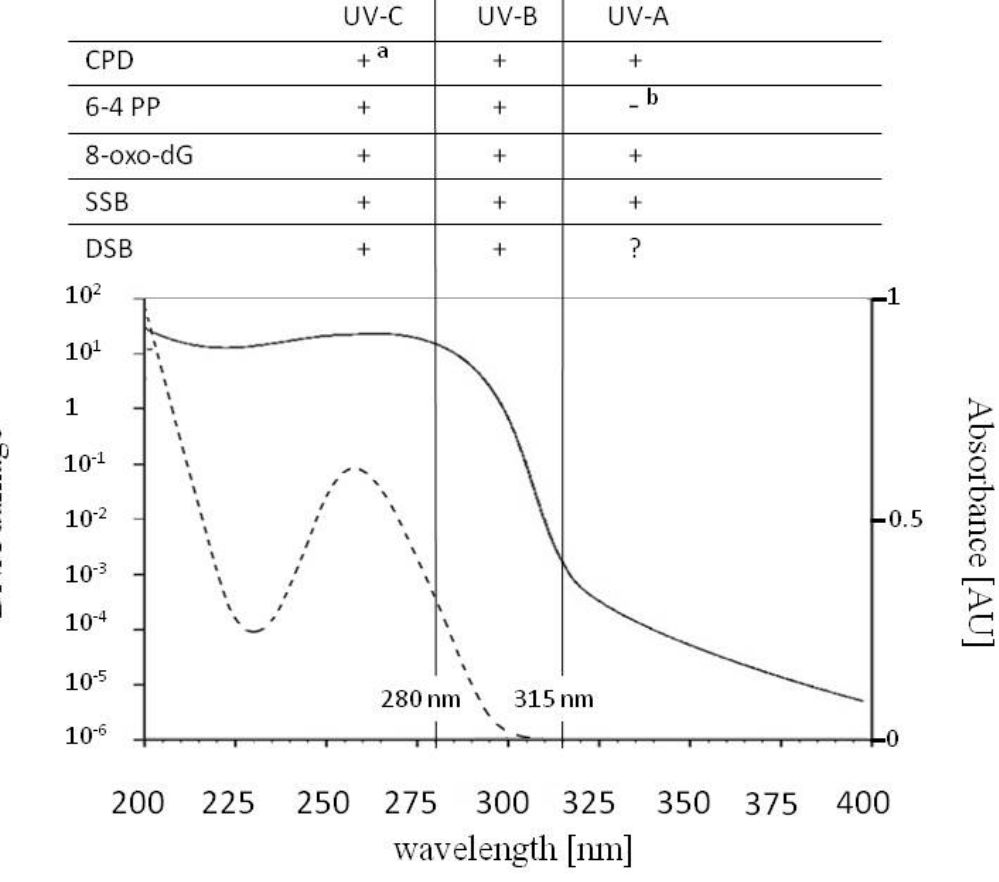
Figure 1. The common DNA lesions induced by UV-A (315–400 nm), UV-B (280–315 nm) and UV-C (100–280 nm), the action spectrum for generalized DNA damage from 200–400 nm (solid line) and the absorption spectrum for DNA with the maximum at 260 nm (dotted line). Cyclobutane pyrimidine dimers (CPDs), 7,8-dihydro-2 ′ -deoxyguanosine (8-oxo-dG) and single strand breaks (SSBs) are formed upon UV-A, UV-B and UV-C radiation. CPDs can undergo photoreversion to undamaged bases upon UV-C radiation (a). UV-B and UV-C are responsible for the formation of (6-4) pyrimidine–pyrimidone photoproducts (6-4 PPs) and double strand breaks (DSBs). The role of UV-A in the direct